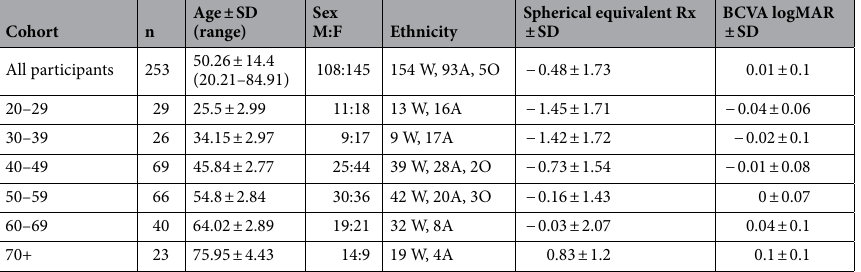
Table 1. Participant demographics based on 10-yearly age interval cohorts. Values are expressed as mean ± standard deviation (SD). Description of demographic characteristics of the study population for 5-yearly age intervals were previously reported by Tong et al. 16 . W, White; A, Asian; O, Other; Rx, refraction; BCVA, best corrected visual acuity.